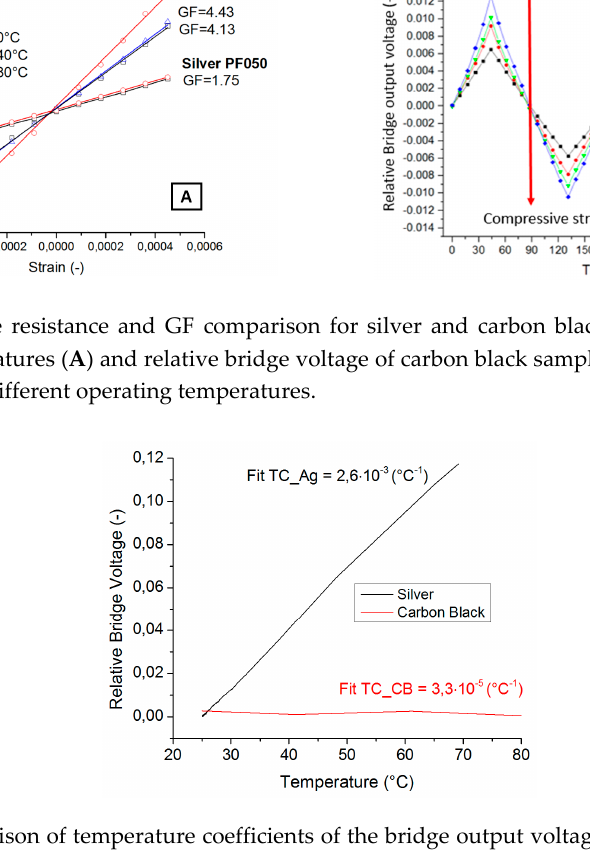
Figure 5. Comparison of temperature coefficients of the bridge output voltage for silver and carbon black sample (measured at zero